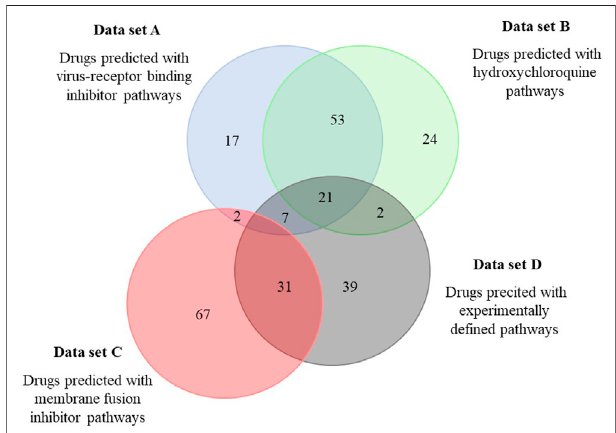
FIGURE 2 | Overlap among drugs identi fi ed by the different pathway sets predicted to be involved in SARS-CoV-2 infection. Pathways relevant for SARS-CoV-2 infection predicted to be affected by three selected drugs were used to identify drugs from the DrugBank. Predicted drugs involved in this analysis are shown in Supplementary Material 3